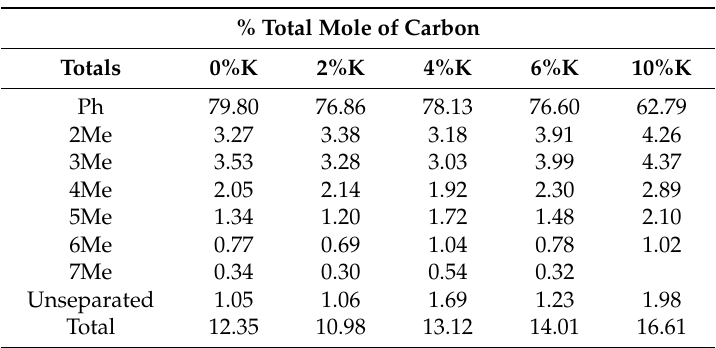
Table 4. The Percentage Difference in Methyl-branched to N-paraffins for a Range of K Promoted Iron Catalysts. Reactor Conditions: 230 ◦ C, 12.1 bar, WHSV = 2, and H 2 /CO =